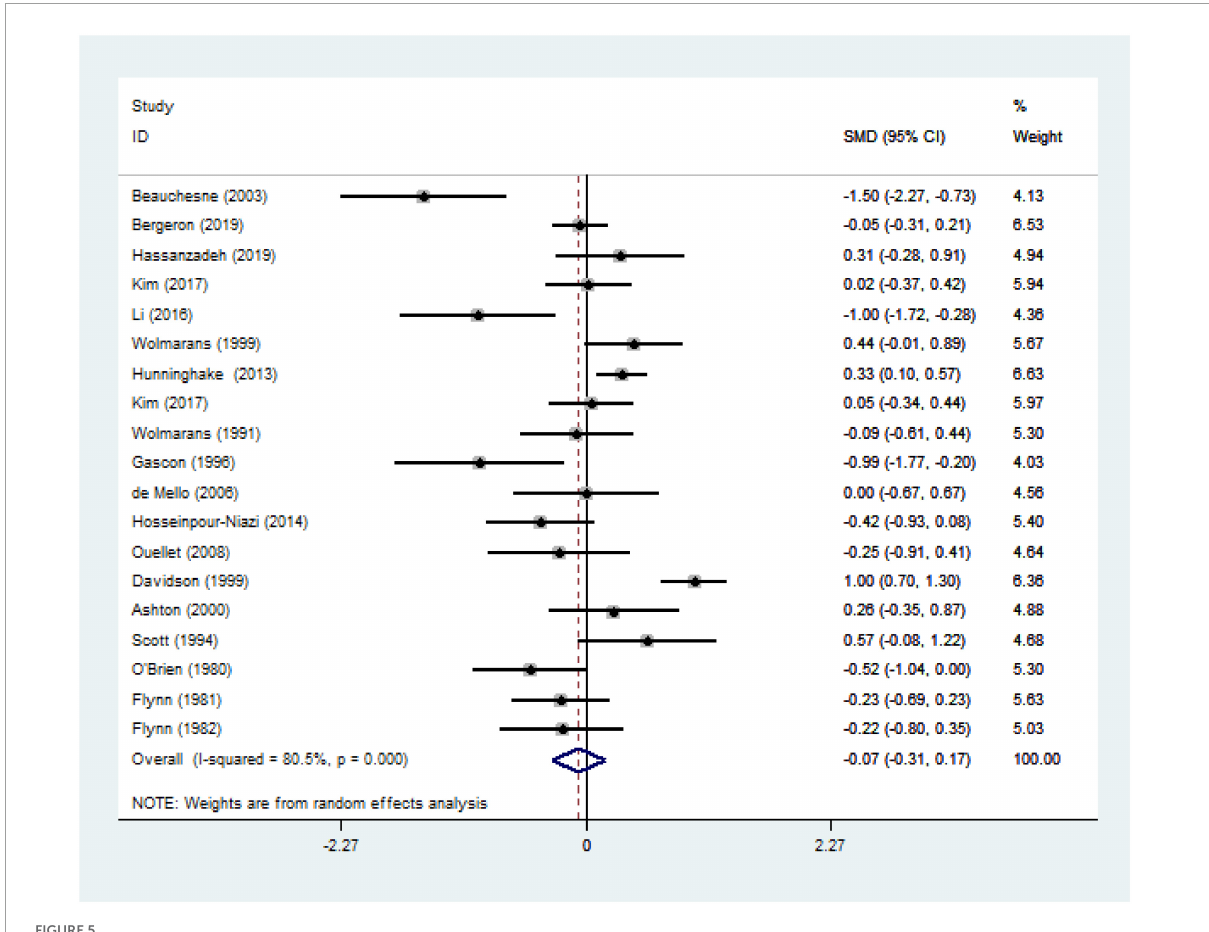
FIGURE5 Effect of red meat consumption on HDL-C concentration. HDL-C, high-density lipoprotein